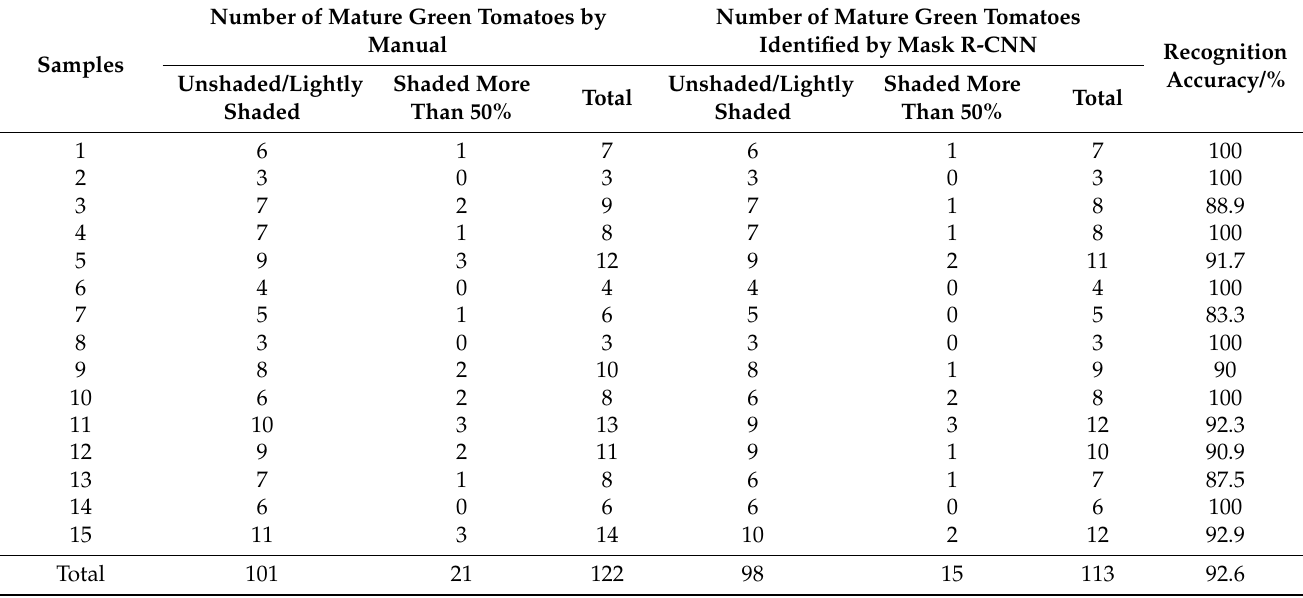
Table 2. Recognition performance comparison between the trained Mask R-CNN model and manual detection.